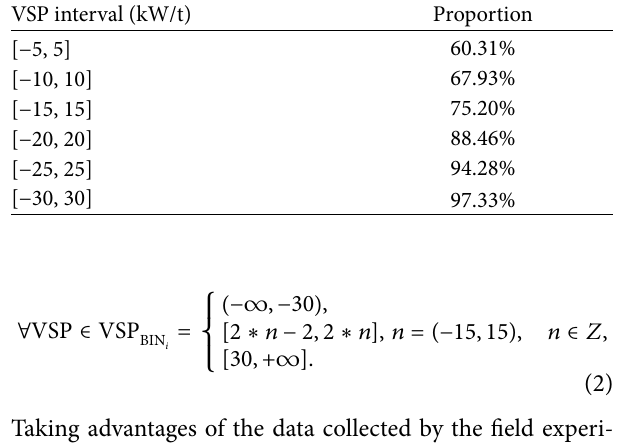
Table 1: Proportions of different VSP intervals. VSP interval (kW/t)